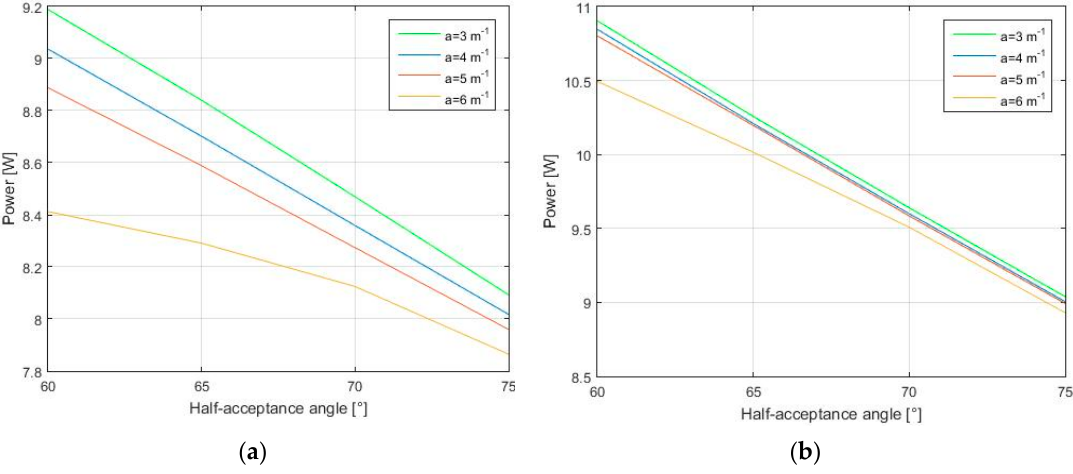
Figure 17. Maximum radiative total heat flux through solar cell n.2 for different half-acceptance angles and parabola coefficients: ( a ) covered CPC system; ( b ) uncovered CPC system.